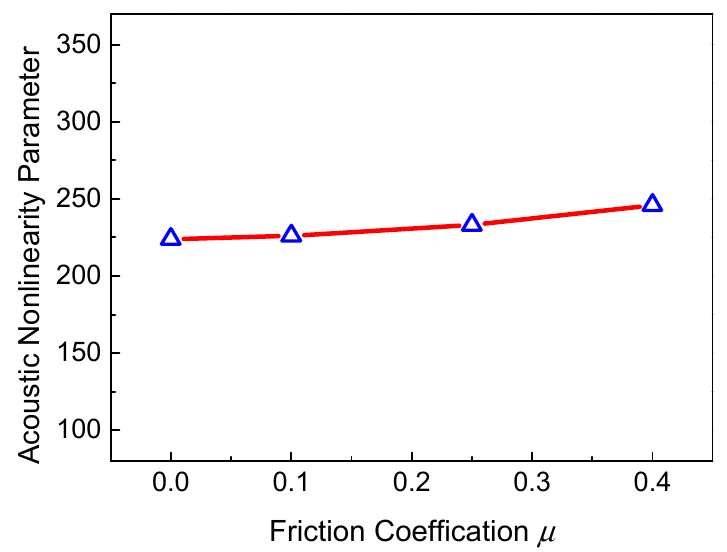
Figure 8. ANP versus friction coefficient ( c = 0.009375, f R = 6 MHz, L 1 = 40 mm, L 2 = 4 mm, L 3 = 36 mm).